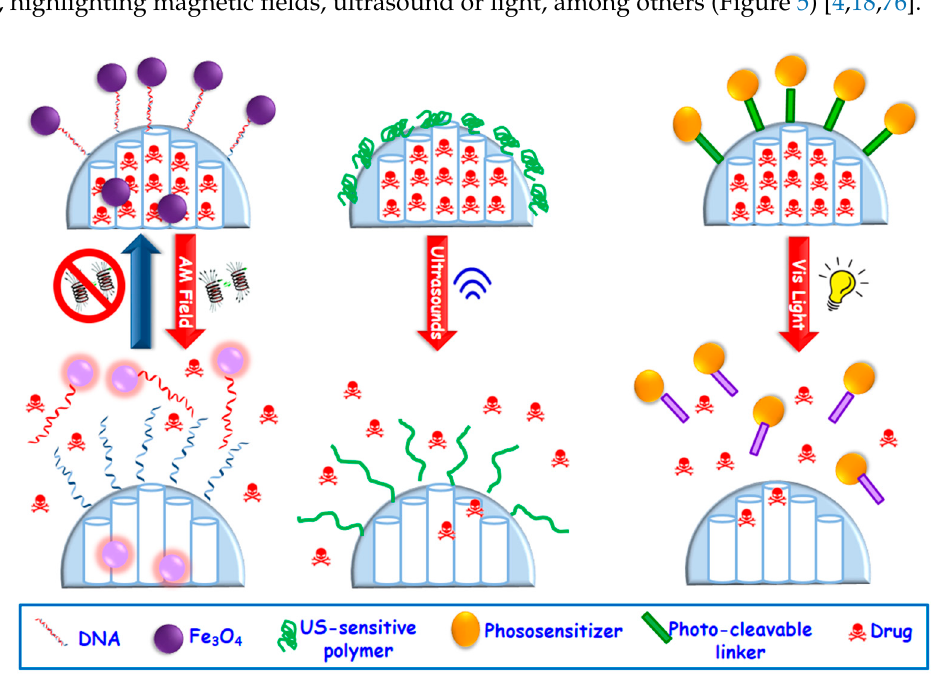
Figure 5. Schematic depiction of three representative external stimuli-responsive drug delivery from MSNs via alternating magnetic fields (AM Field), ultrasounds (US) and visible (Vis) light (from left to right).